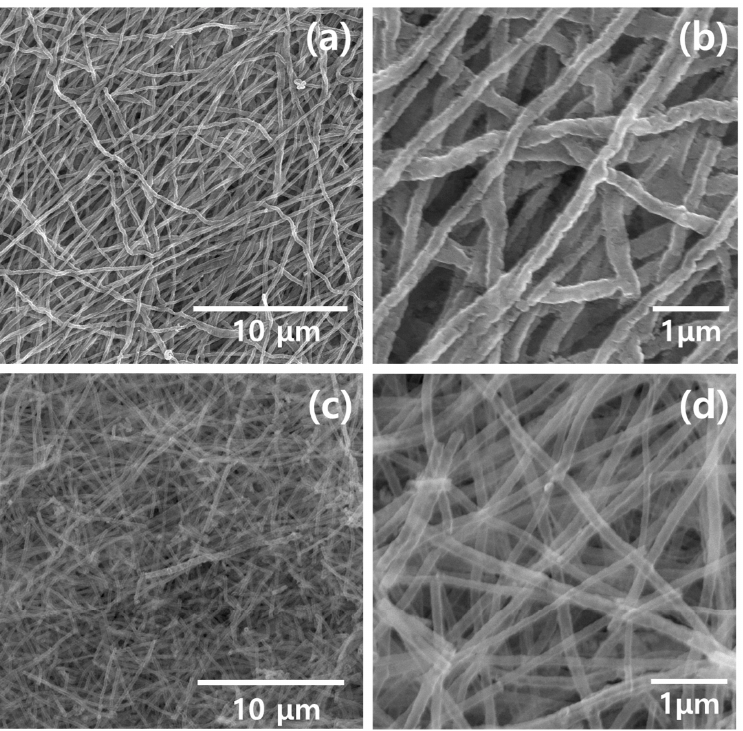
Figure 2. Field-emission scanning electron microscope images of nanofibers: ( a ) low-magnification images of the TiO 2 nanofiber, ( b ) high-magnification images of the TiO 2 nanofiber, ( c ) low-magnification images of the Fe-doped TiO 2 nanofiber, and ( d ) high-magnification images of the Fe-doped TiO 2 nanofiber.